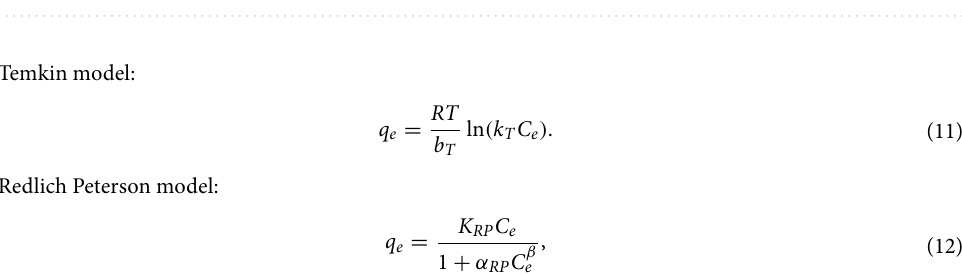
Figure 2. Effect of different irradiation dose and graft reaction time on degree of grafting of GMA on PA6 (Monomer concentration (5%) TW20 (0.5%), at 40